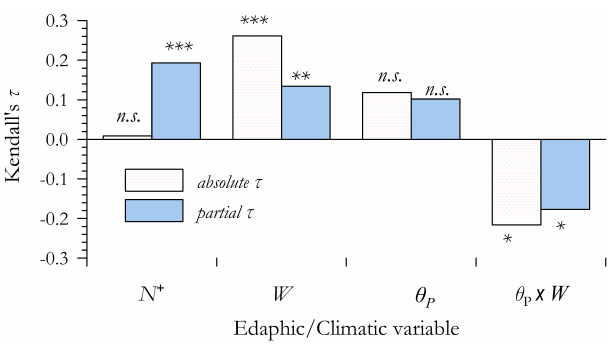
Figure 11. Absolute and partial Kendall’s τ for the association be- tween absolute and partial Kendall’s τ for canopy area index as a function of exchangeable nutrient cation content ( N + ), mean an- nual cumulative soil water deficit ( W ), soil plant available water storage ( θ P ) and a θ P × W interaction term. Open red bars: absolute τ ; Closed blue bars: partial τ ; * is significant at p < 0 . 050; ** is significant at p < 0 . 010; *** is significant at p < 0 . 005; n.s. is not significant ( p > 0 .